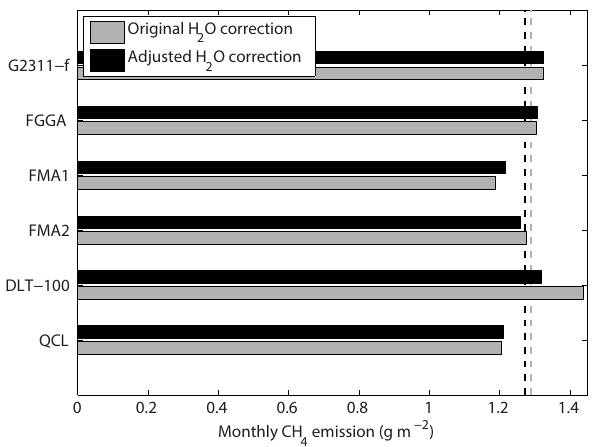
Figure 14. Monthly CH 4 emissions estimated from mean CH 4 fluxes observed during part of the campaign (from 12 to 25 June). Data corrected with the original H 2 O correction are shown with grey bars and with the adjusted H 2 O corrections ( − kF WPL to the fluxes) are shown with black bars. Vertical dashed lines show the mean